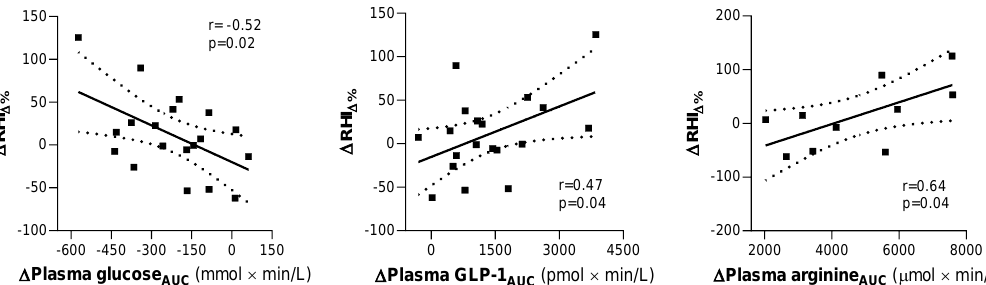
Figure 4. Correlations between differences in RHI percentage changes at the end of the preload vs. control study (ΔRHI Δ % ) and changes in the areas under the curve (AUC) of plasma glucose (Δglucose AUC ), glucagon-like peptide- 1 (ΔGLP -1 AUC ), and arginine (Δarginine AUC ) in subjects with abnormal glucose tolerance.